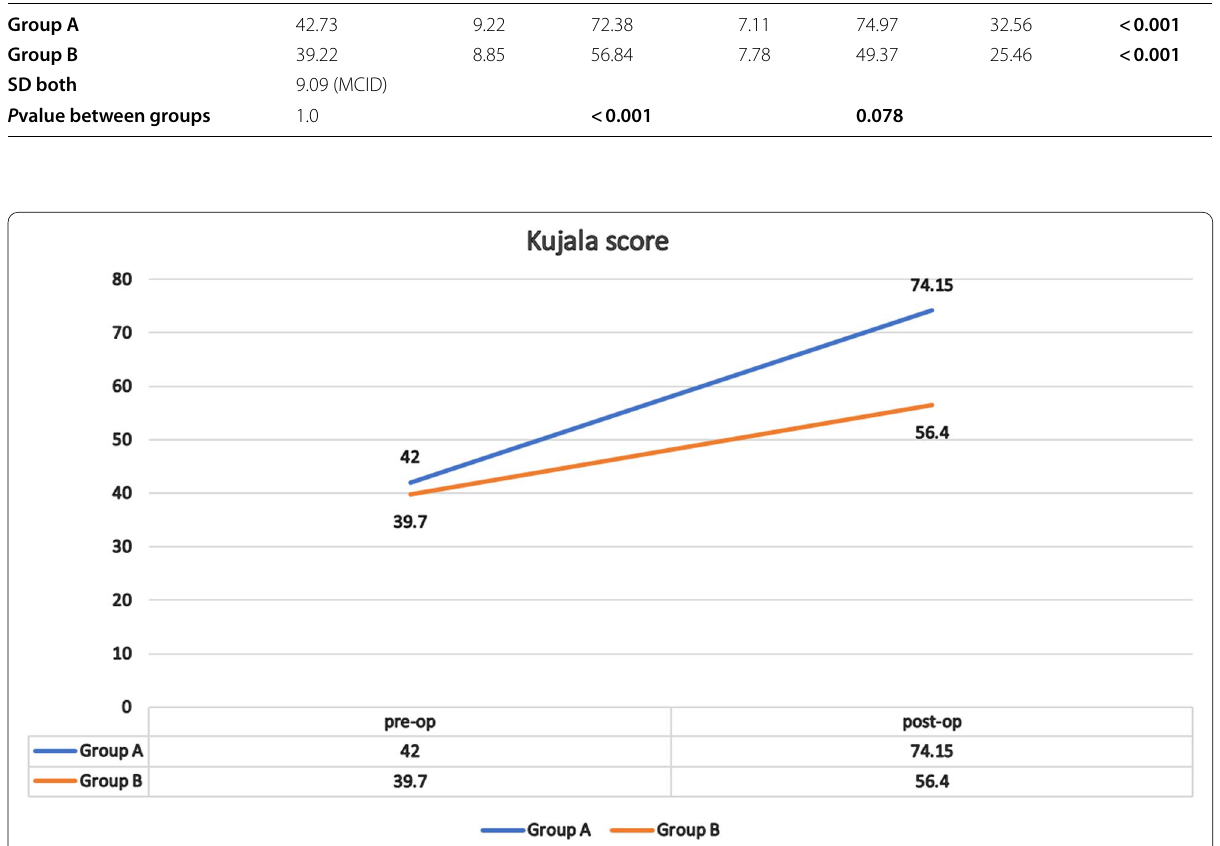
Fig. 14 Pre‑ and postoperative KUJALA scores with % difference from baseline in both